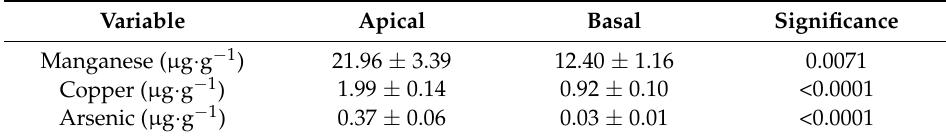
Table 3. The influence of axial position within Cycas micronesica stems on various elements. Means are combination of pith, vascular, and cortex radial stem regions. Data were presented as mean ± standard error for n = 30.